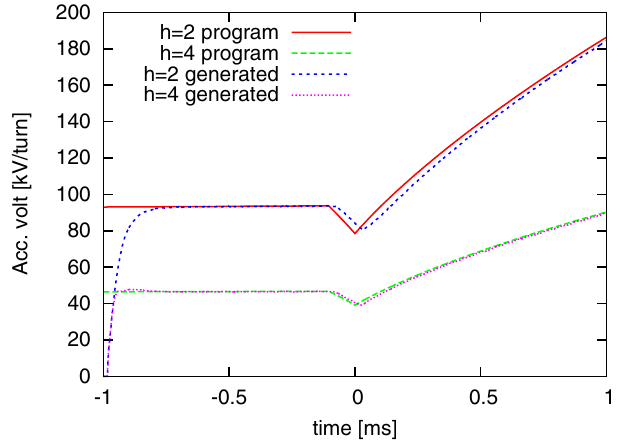
FIG. 19. (Color) Bunch shape with the second harmonic rf and 0.1% of momentum-offset injection. The full width of the bunch is 450